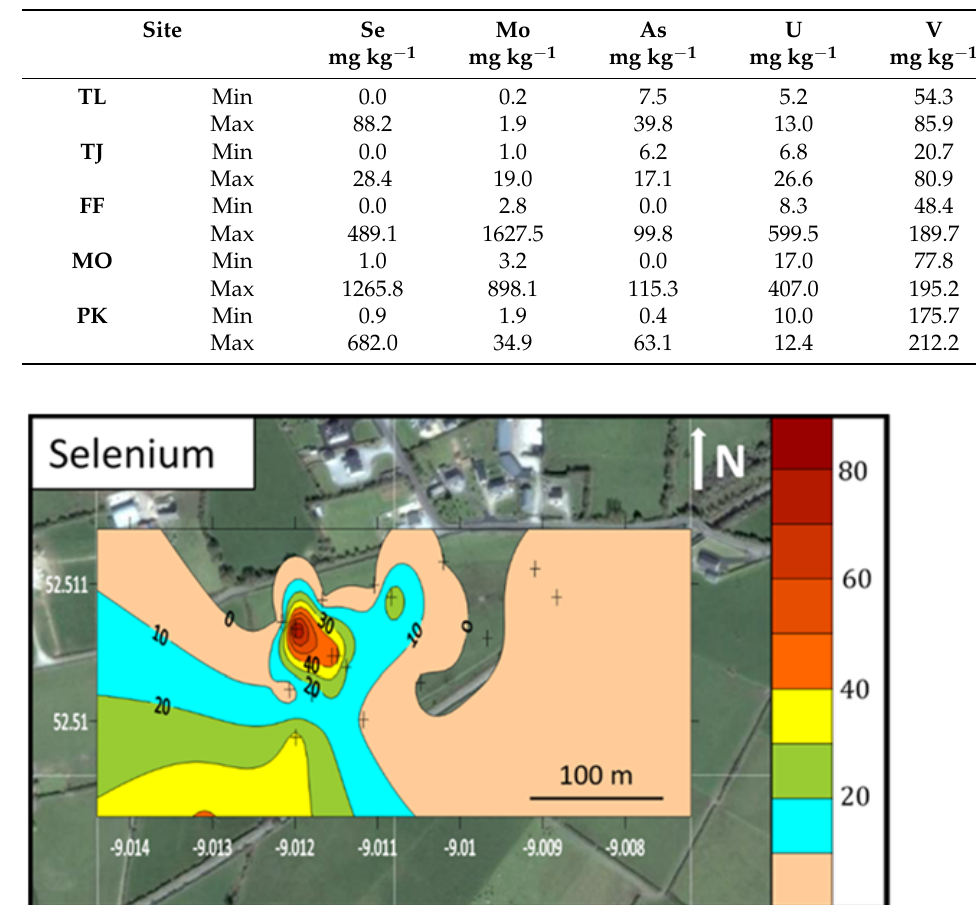
Figure 2. Map showing the spatial distribution of selenium in soil at 10–20 cm at site TL, produced using Golden LLC Surfer ® V15 software and superimposed on a satellite image of Clonaugh, West Limerick (52°30 ′ 38 ′′ N, 9°0 ′ 43 ′′ W) (Google Earth Pro, ©Google. Image© Maxar Technologies, using Kriging griding). Sample site marked with a +, scale in ppm, axes in longitude and latitude. Table 1. The maximum and minimum concentrations of key elements derived from bulk samples collected at 10–20 cm depth from five agricultural sites in West Limerick, determined by XRF.